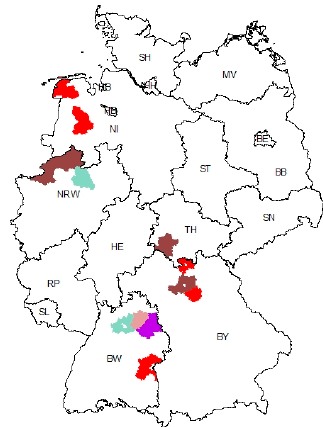
Figure 4. Geographic distribution of PEDV strains in Germany (federal states are presented by the second part of their regional code according to ISO 3166-2). Regions colored red represent the presence of viruses of cluster 1 (parts of Lower Saxony, NI; Bavaria, BY; Baden-Wuerttemberg, BW) and regions colored walnut the presence of viruses of cluster 2 (North Rhine-Westphalia, NRW; Thuringia, TH; Bavaria, BY), respectively. The regions of the first PEDV cases in Europe (Cluster 3) are highlighted light blue/green (border region between NRW and NI, BW). Violet color points to a regional overlap of cluster 1 with ungrouped samples L00798 K11/14-02 and L00799 K11/14-01 (BW).